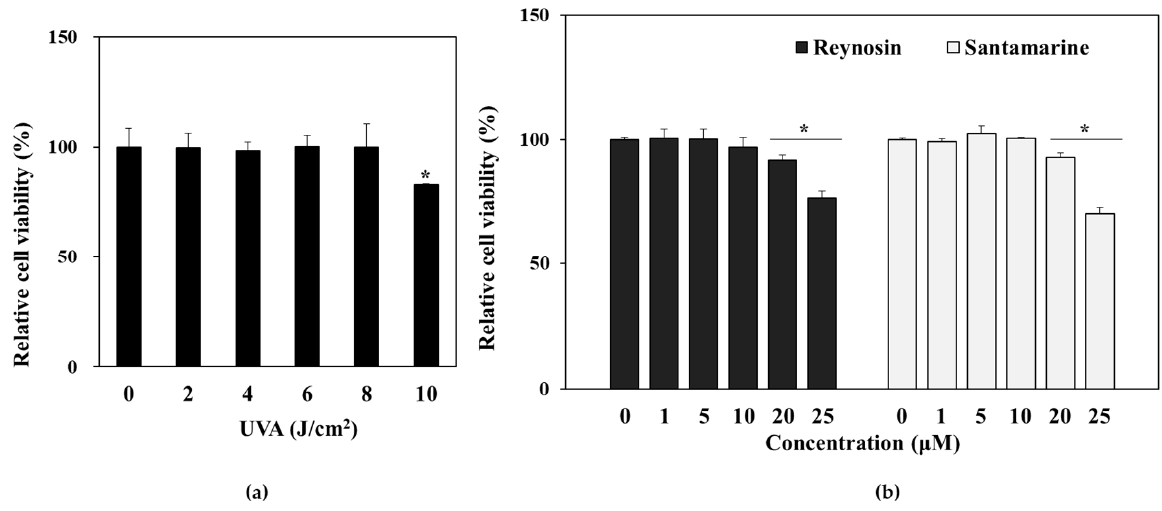
Figure 2. Effect of UVA ( a ) and reynosin and santamarine ( b ) on the viability of human derma fibroblasts (HDFs). Viability of the cells was measured after 24 h treatment with MTT assay. Viability was given as relative percentage of the untreated group. Values are means ± SD ( n = 3). * p < 0.05, vs. untreated control.